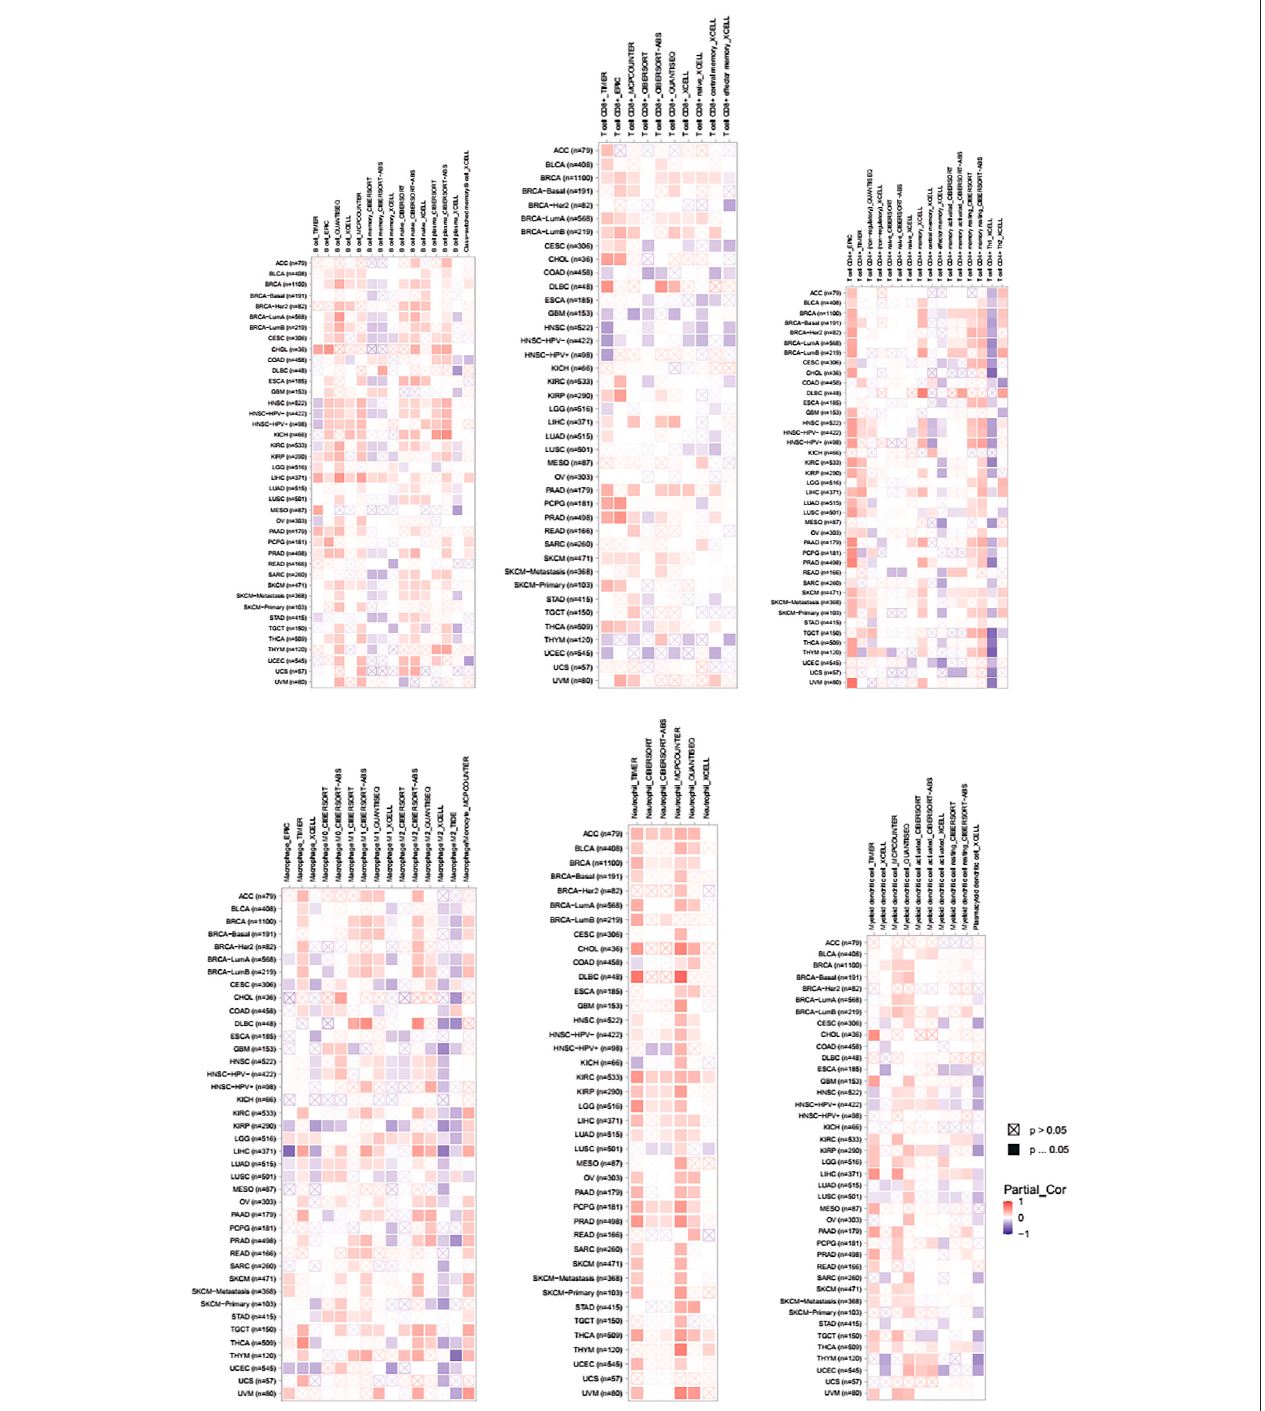
FIGURE5| AssociationsofPLAGL2expressiontotumorpurityandimmunein fi ltrationinvariouscancers.Associationheatmapofimmunecellin fi ltrationbasedon B cells, CD8 + T cells, CD4 + T cells, macrophages, neutrophils, and DCs in multiple cancer types.